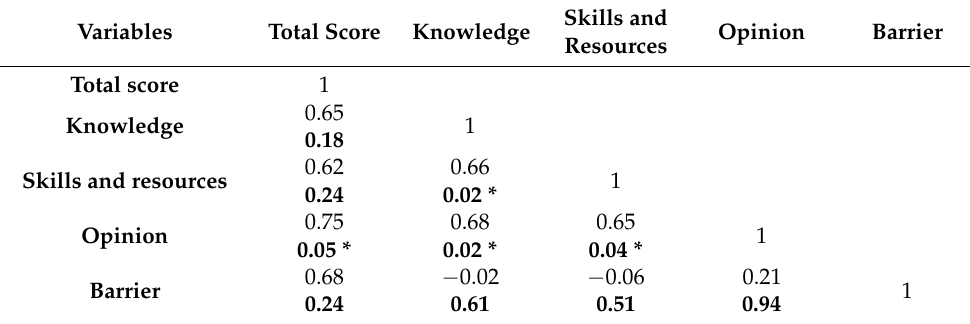
Table 7. Pearson’s correlation matrix between each score.